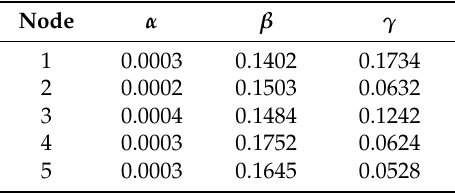
Table 3. The parameters of the five-MESCs system using the average allocation method.